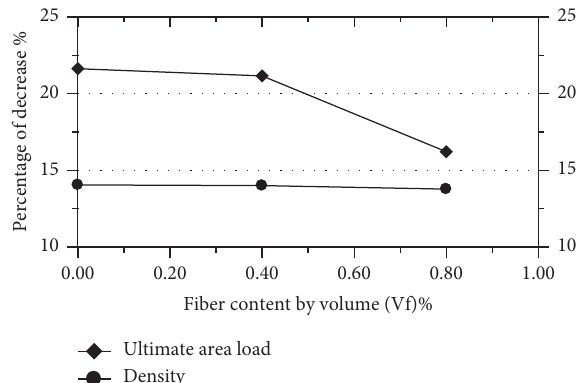
Figure 9: Percentage of decreasing in the ultimate uniform load and density when replacing normal-weight by lightweight aggregate.